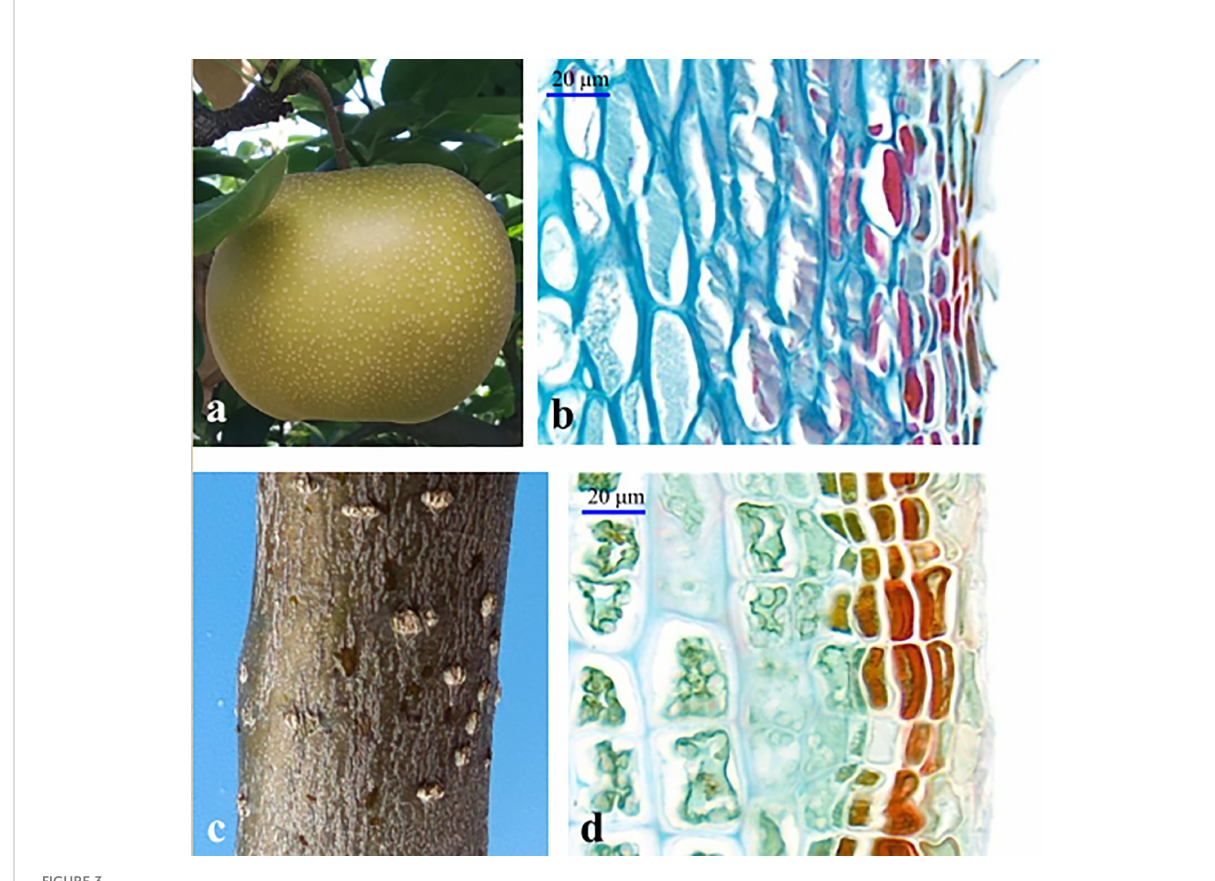
FIGURE 3 The periderm development in sand pear fruit (A, B) and stem (C, D)